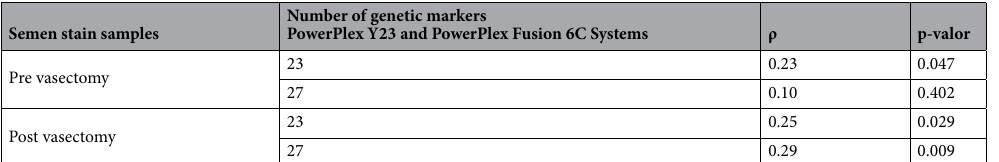
Table 1. Spearman correlation (ρ) between measures of DNA concentration and count of markers of PowerPlex Y23 and PowerPlex Fusion 6C Systems from pre- and post-vasectomy stain samples (90 individuals).